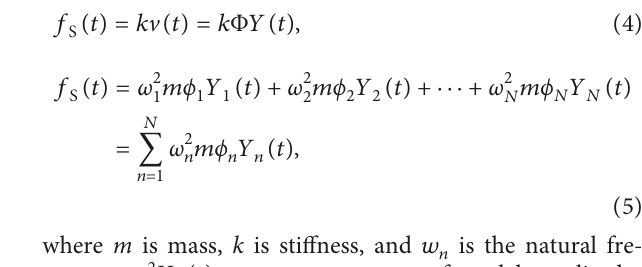
Figure 16: Modal shapes of side wall of the building. (a) Mode 1 ( f Mode 4 ( f 4 � 88.92Hz). (e) Mode 5 ( f 5 � 93.27Hz). (f) Mode 6 ( f 6 � 93.57Hz). (g) Mode 7 ( f 7 � 98.38Hz). (h) Mode 8 ( f 8 � 136.84Hz). (i) Mode 9 ( f 9 � 146.16Hz). (j) Mode 10 ( f 10 �